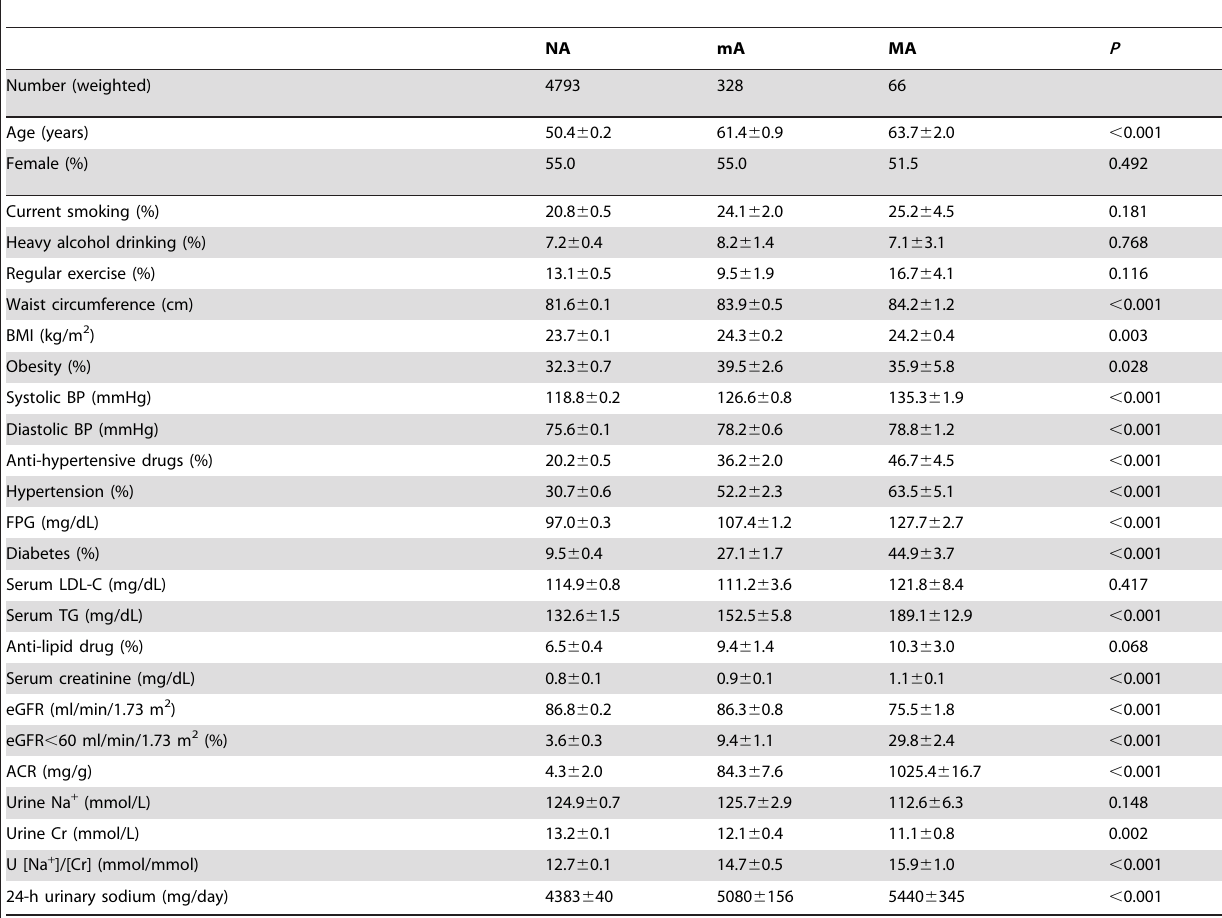
Table 1. Age, sex, and age- and sex-adjusted demographic and clinical characteristics of the Korean population, age 19 years and older, in the 2011 KNHANES according to